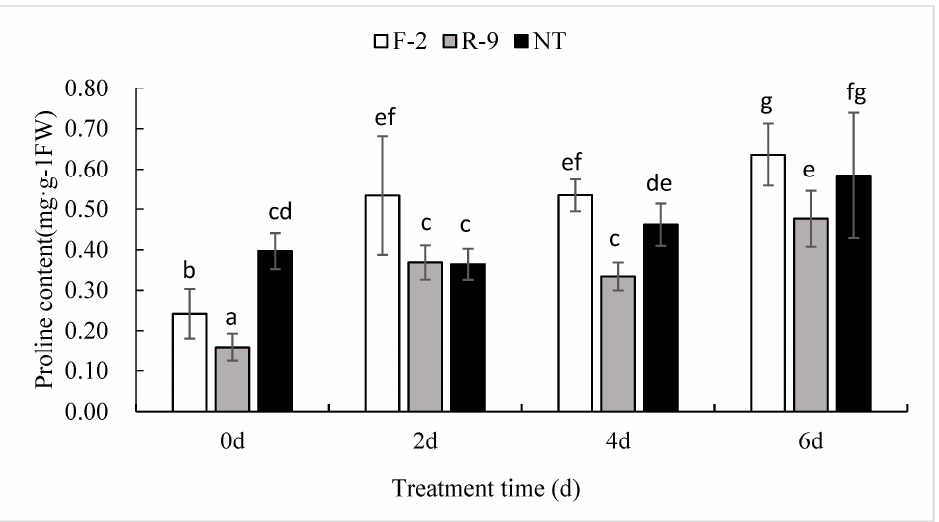
Figure 9. Proline content of ScD27.2 F-2 and ScD27.2R-9 transgenic lines and NT non-transgenic controls. Duncan’s new multiple range methods were used to analyze significant differences in gene expression at different time points after 6 days of stress treatment in 20% PEG-8000 MS medium. Different lowercase letters indicate significant differences at the 0.05 level. The error line represents the standard error ( n = 9).